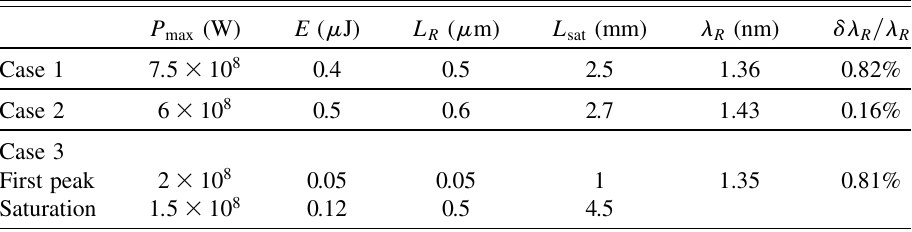
TABLE II. Radiation